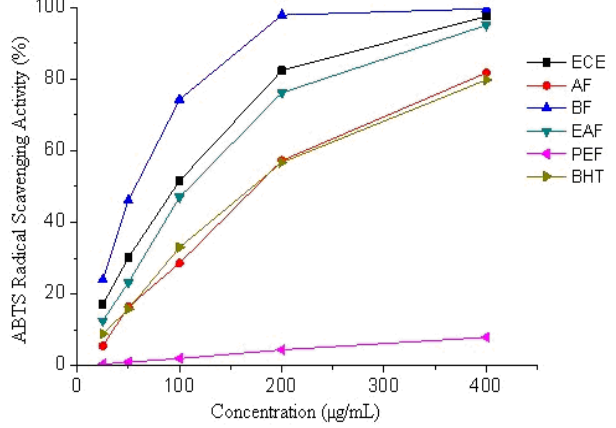
Figure 2. ABTS radical scavenging activity of ethanolic crude extract and fractions of Receptaculum